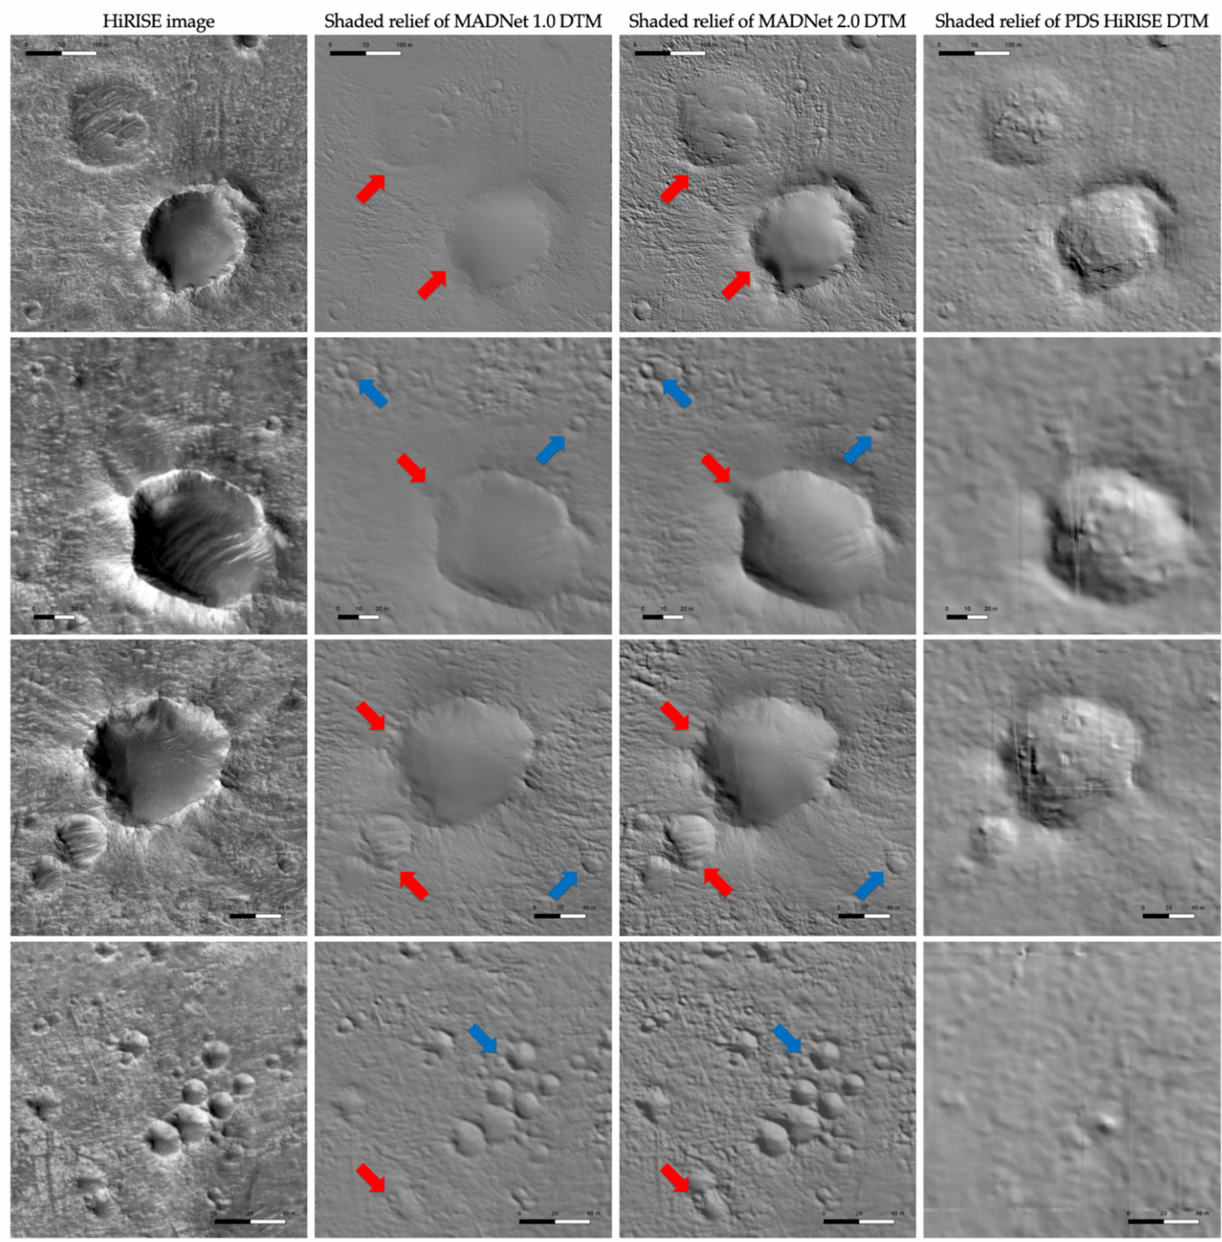
Figure 7. Examples of HiRISE (ESP_003195_1985_RED) image crops and the hill-shaded (azimuth: 225 ◦ ; altitude: 30 ◦ ; vertical exaggeration: 1) relief images from the MADNet 1.0 DTM, MADNet 2.0 DTM, and PDS HiRISE DTM, showing that the intermediate-scale and large-scale topographic information (red arrows) are missing or smoothed out for MADNet 1.0 DTMs, whereas the fine-scale topographic information (blue arrows) is well-retrieved for both the MADNet 1.0 and MADNet 2.0